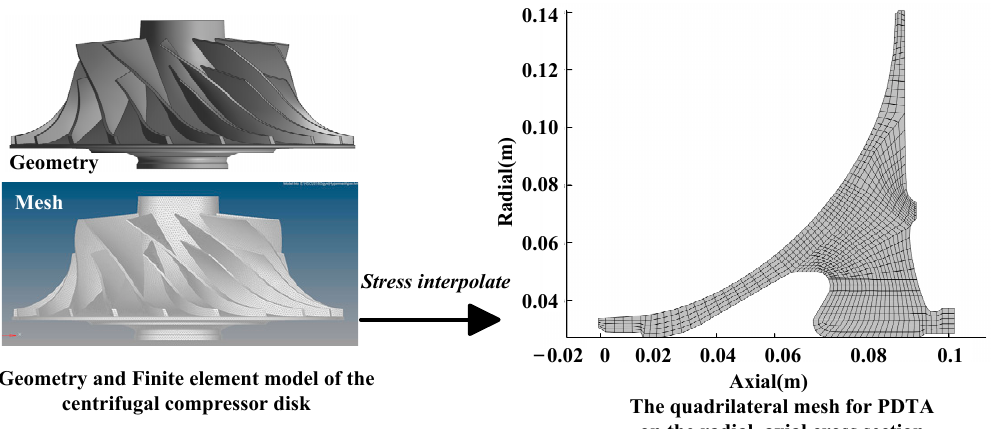
Figure 10. Geometry, finite element model, and the quadrilateral mesh of the compressor disk. Table 1. Boundary conditions in the steady state [35].